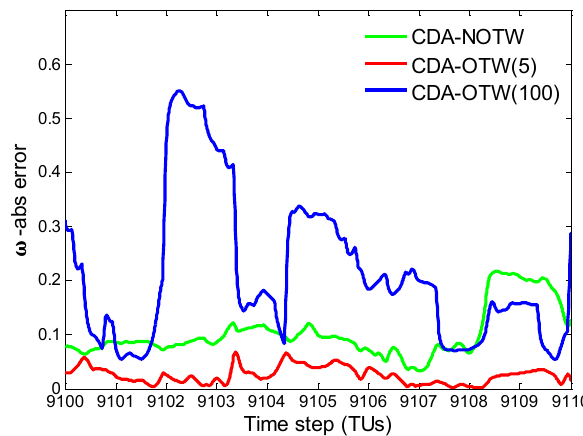
Figure 2. Time series of the absolute errors of the slab ocean variable ( ω) in three assimilation experiments based on the model states between 9100 and 9110TUs assimilation results in the per- fect model experiment framework with the univariate adjustment scheme. Green – CDA control with the standard update intervals of 0.05TU for X 1 , 2 , 3 and 0.2TU for ω ; red – CDA with an ocean observational time window (OCN-OTW) of five time steps (OCN- OTW (5)); blue – CDA with OCN-OTW